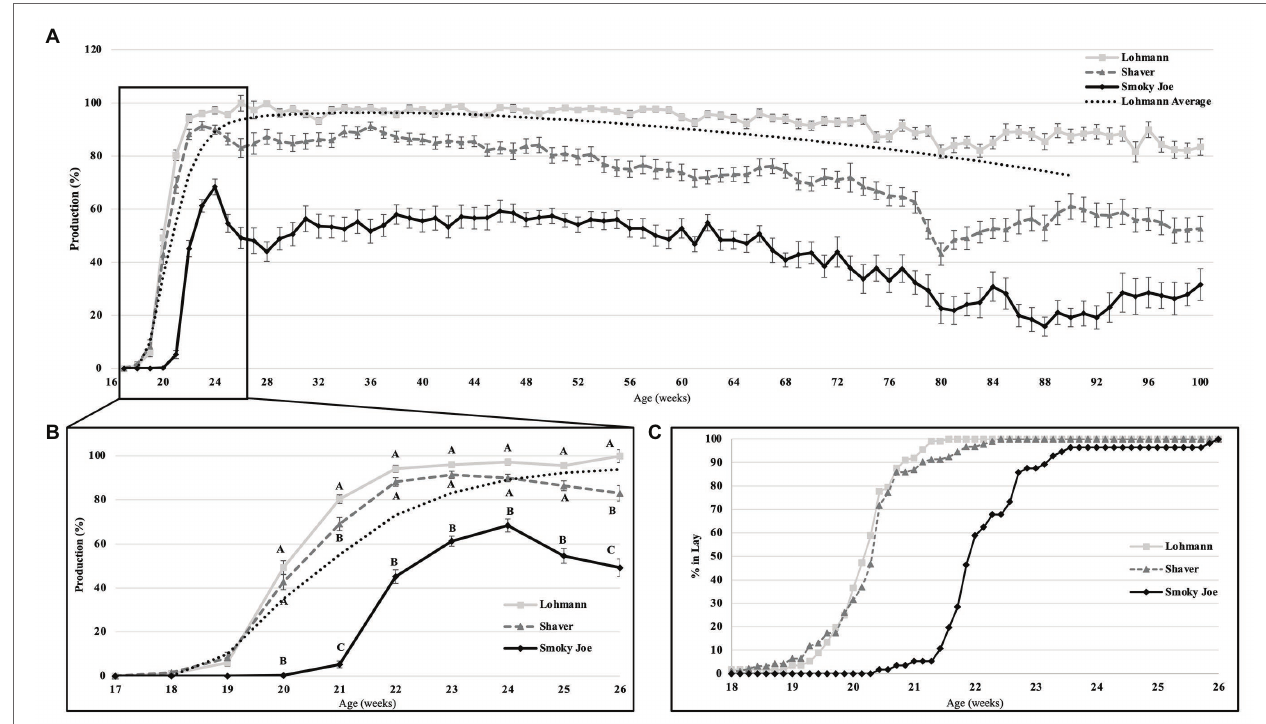
FIGURE 4 | The rate of egg production in Lohmann, Shaver, and Smoky Joe hens up to 100 woa (A) , along with an emphasis on production from 17 to 26 woa (B) , and the associated percentage of hens in each strain, which have initiated lay per week (C) . p -values for the sources of variation: Age, p < 0.0001; Strain, p < 0.0001; and Age * Strain, p < 0.0001. A,B,C Data points lacking the common superscript in (B) differ significantly within the ages of each strain, while no superscript indicates no difference from any other strain at that time